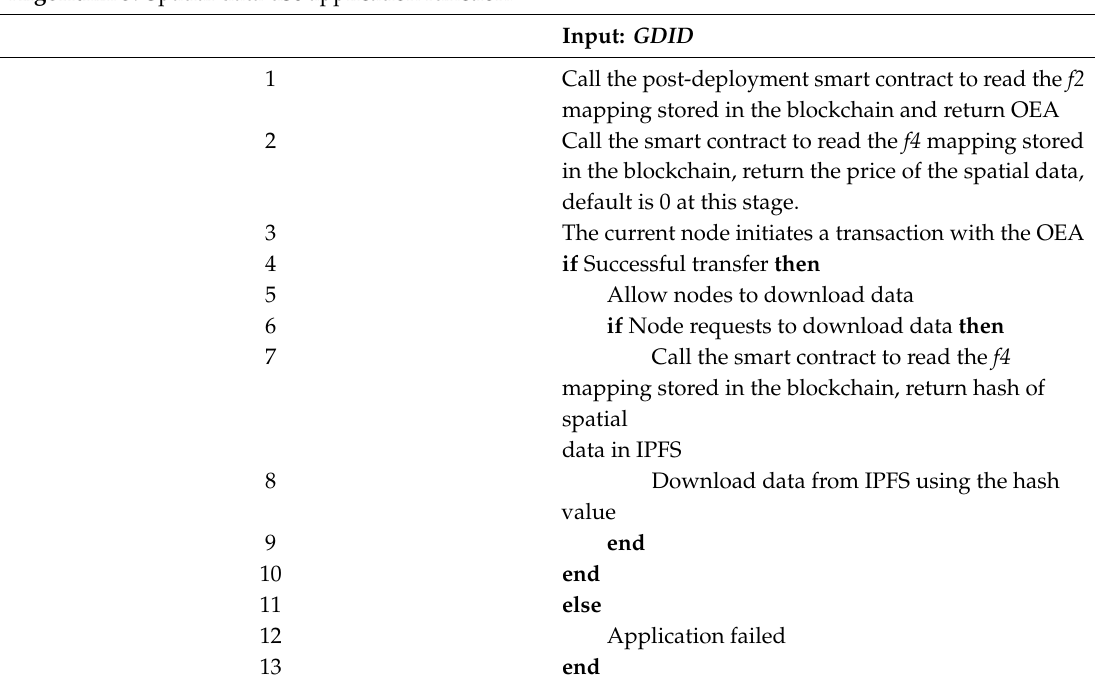
Algorithm 3. Spatial data use application